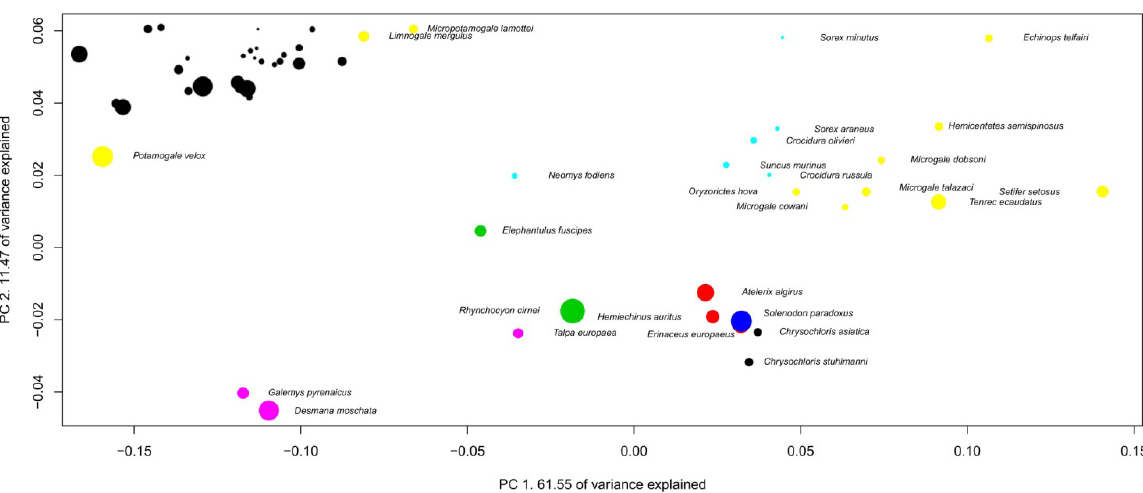
Figure 2. Phylogenetic Principal Component Analysis (PPCA) of insectivores’ brain structure proportions. Regression on independent contrasts of logged absolute brain size onto independent contrasts of position on PC1: Multiple R -squared: 0.067, F -statistic: 1.870 on 1 and 26 DF, P = 0.1832; PC2: Multiple R -squared: 0.289, F -statistic: 10.58 on 1 and 26 DF, P = 0.003156. Families are: black: Chrysochloridae, red: Erinaceidae, green: Macroscelididae, dark blue: Solenodontidae, light blue: Soricidae, purple: Talpidae, yellow: